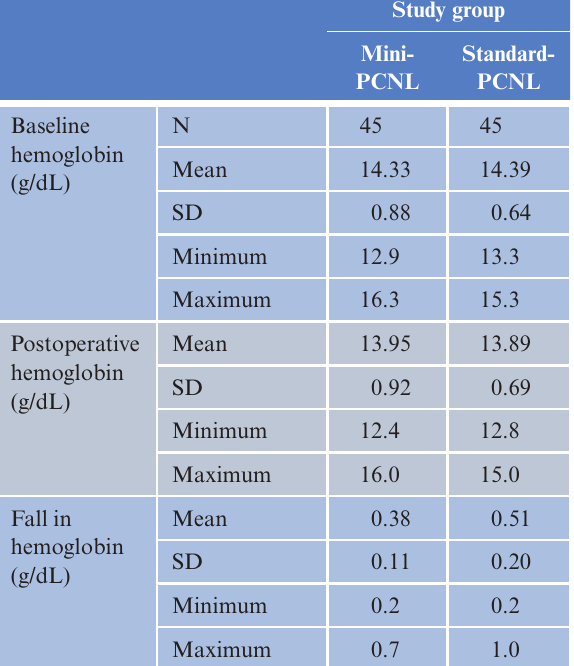
Table 3: Comparison of hemoglobin level at baseline, post- operative, and fall in hemoglobin in both